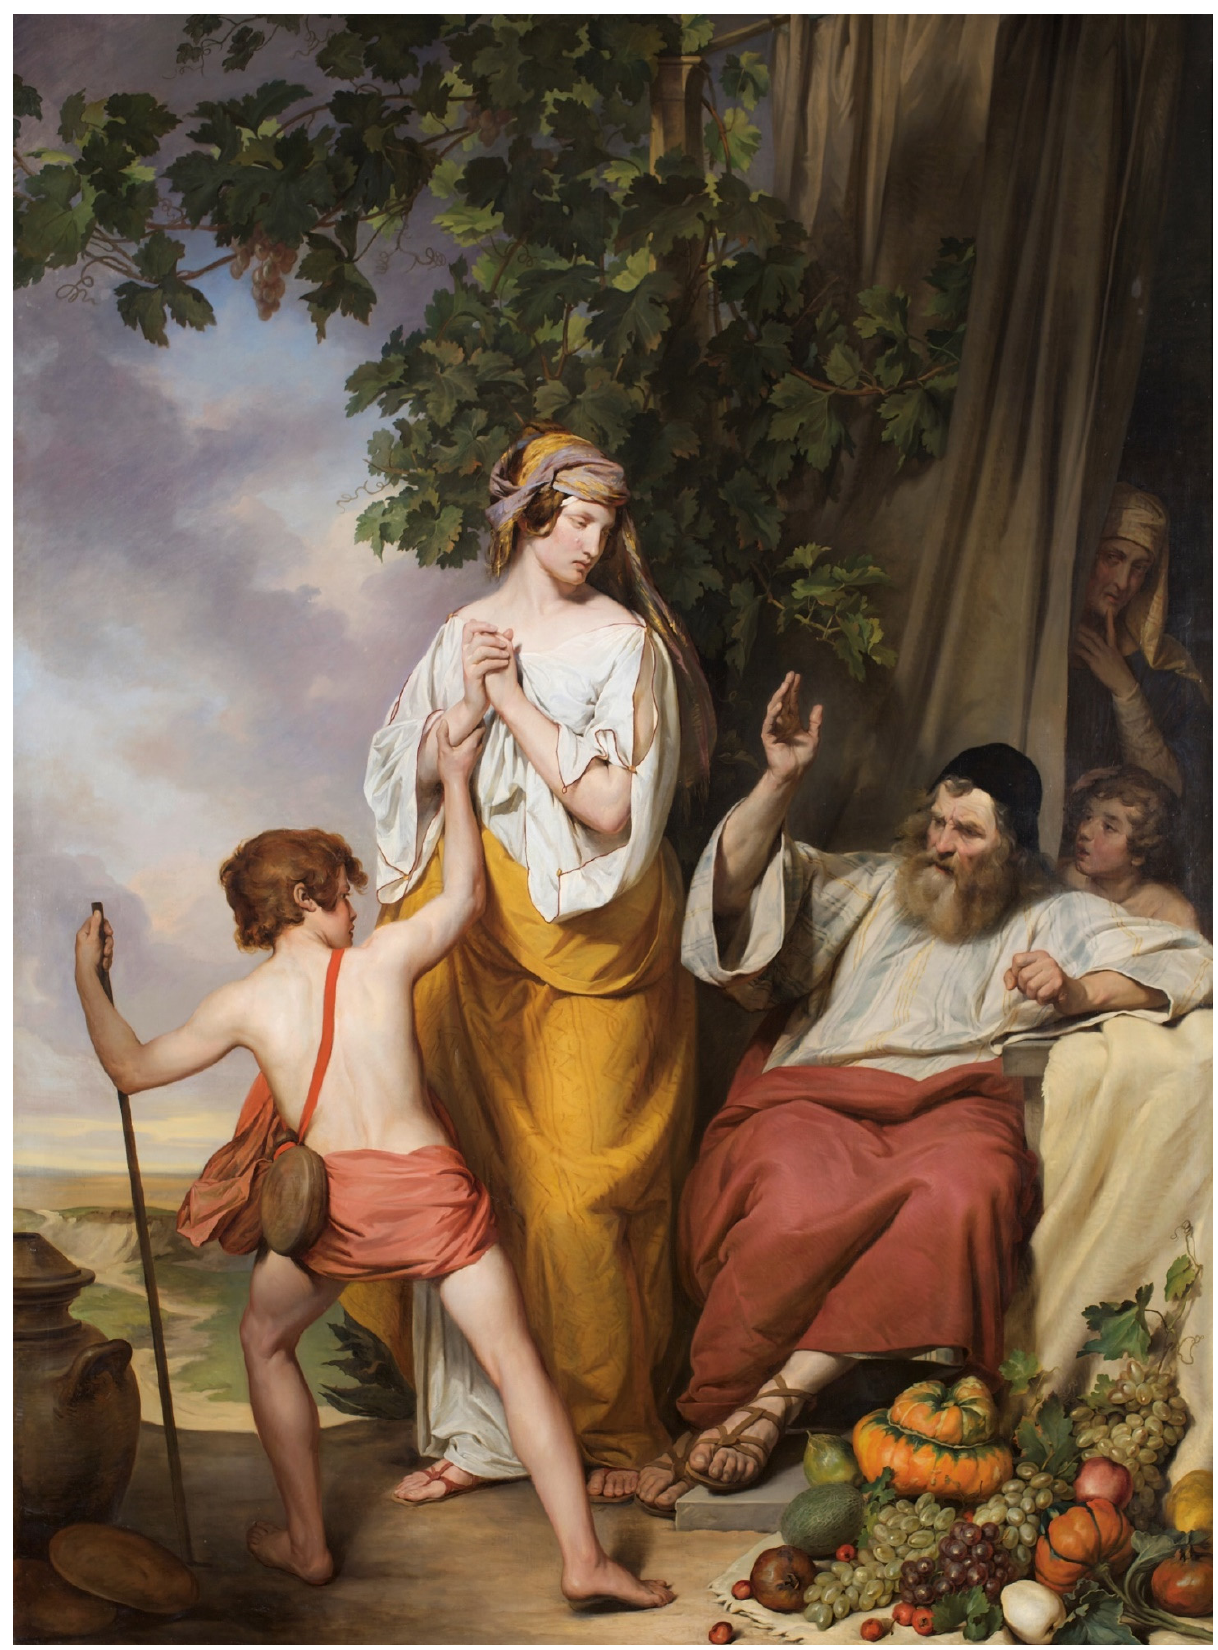
Figure 18. Josef Danhauser, ca. 1836, Vienna, Kunsthistorisches Museum, n. 2553.